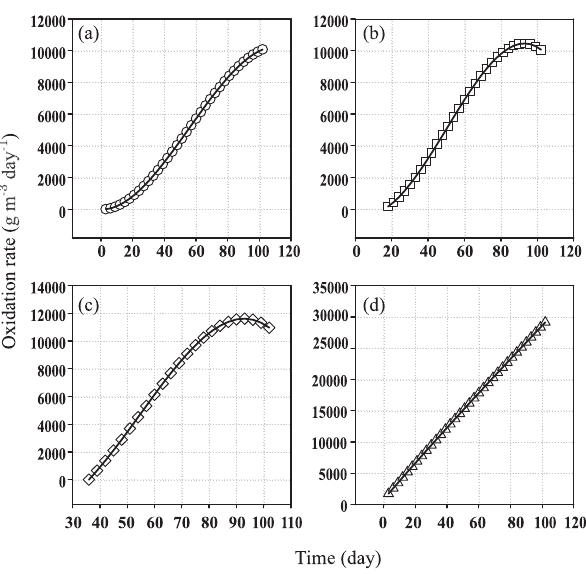
figure 4. methane oxidation rate.